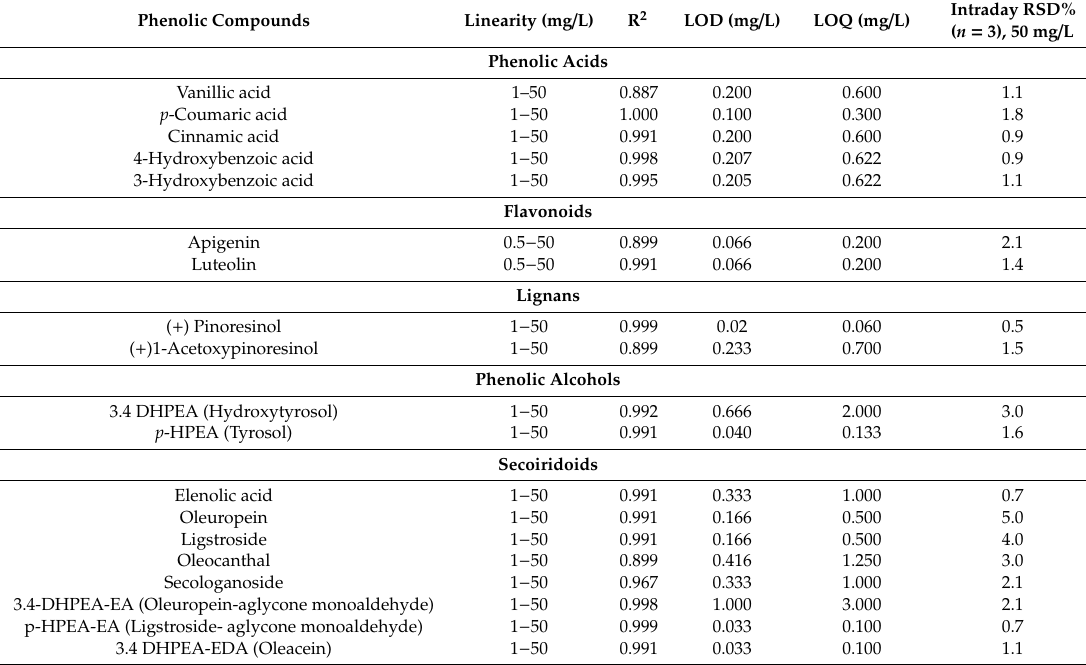
Table 2. Validation parameters of the quantification method.